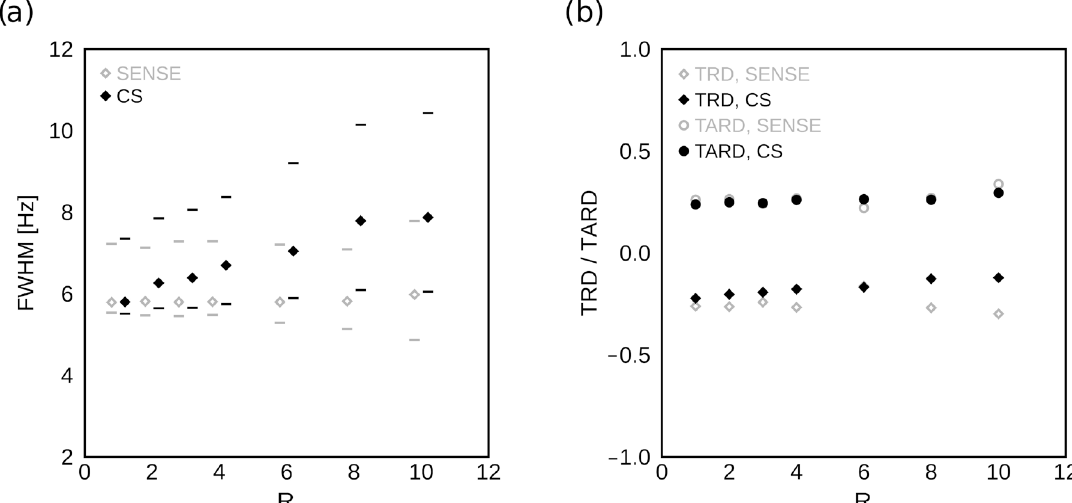
Figure 7. Spectral lineshape descriptors as a function of R. ( a ) The dependence of the ROI-averaged FWHM on the acceleration factor R is shown for SENSE- (gray) and CS-based (black) acceleration. The horizontal lines represent the minimum and maximum values of FWHM in the ROI used for analysis. There is little variation with R in the minimal FWHM values or under SENSE acceleration generally. ( b ) The dependence of TRD and TARD on the acceleration factor R is shown for SENSE- (gray) and CS-based (black) acceleration. While the effects of increasing R on TRD diverge between SENSE and CS, they are minimal. TARD shows virtually no variation with R for either acceleration method.